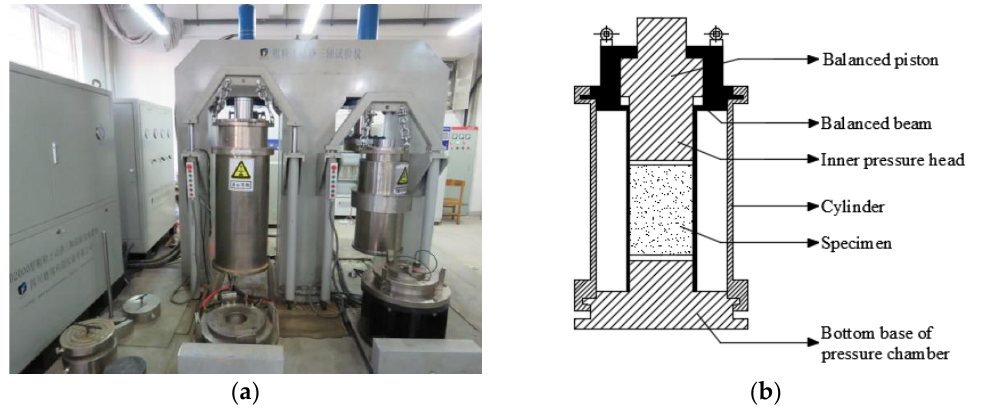
Figure 3. Test setup: ( a ) servo-hydraulic static and dynamic triaxial testing system; ( b ) schematic of the system.